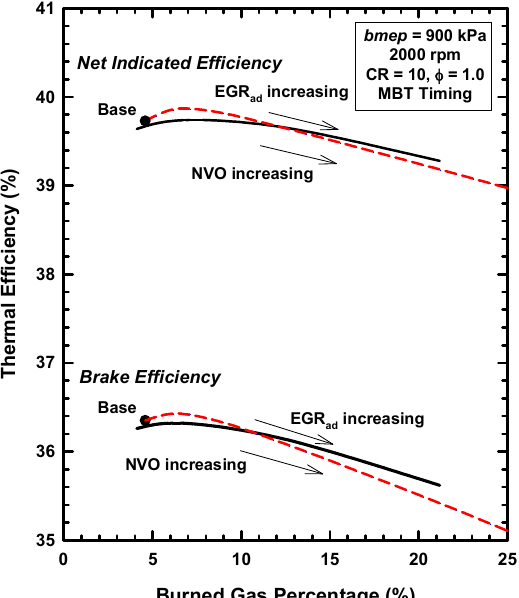
Figure 23. Net indicated and brake thermal efficiencies as functions of the burned gas percentage for both the NVO and the adiabatic EGR strategies.